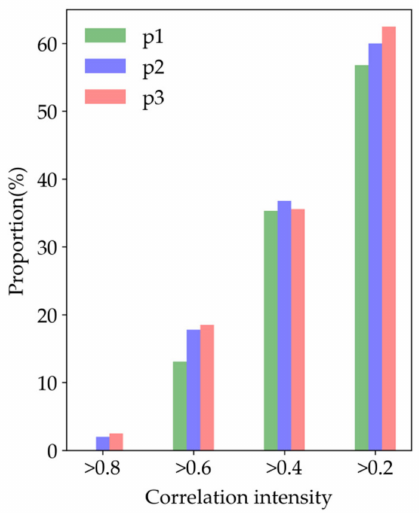
Figure 10. The proportion of the different correlation intensities between the Niño-3.4 index and zonal SSW anomaly field in the main coupling region (black dashed box in Figure 9). The p1, p2, and p3 are the same as in Figure